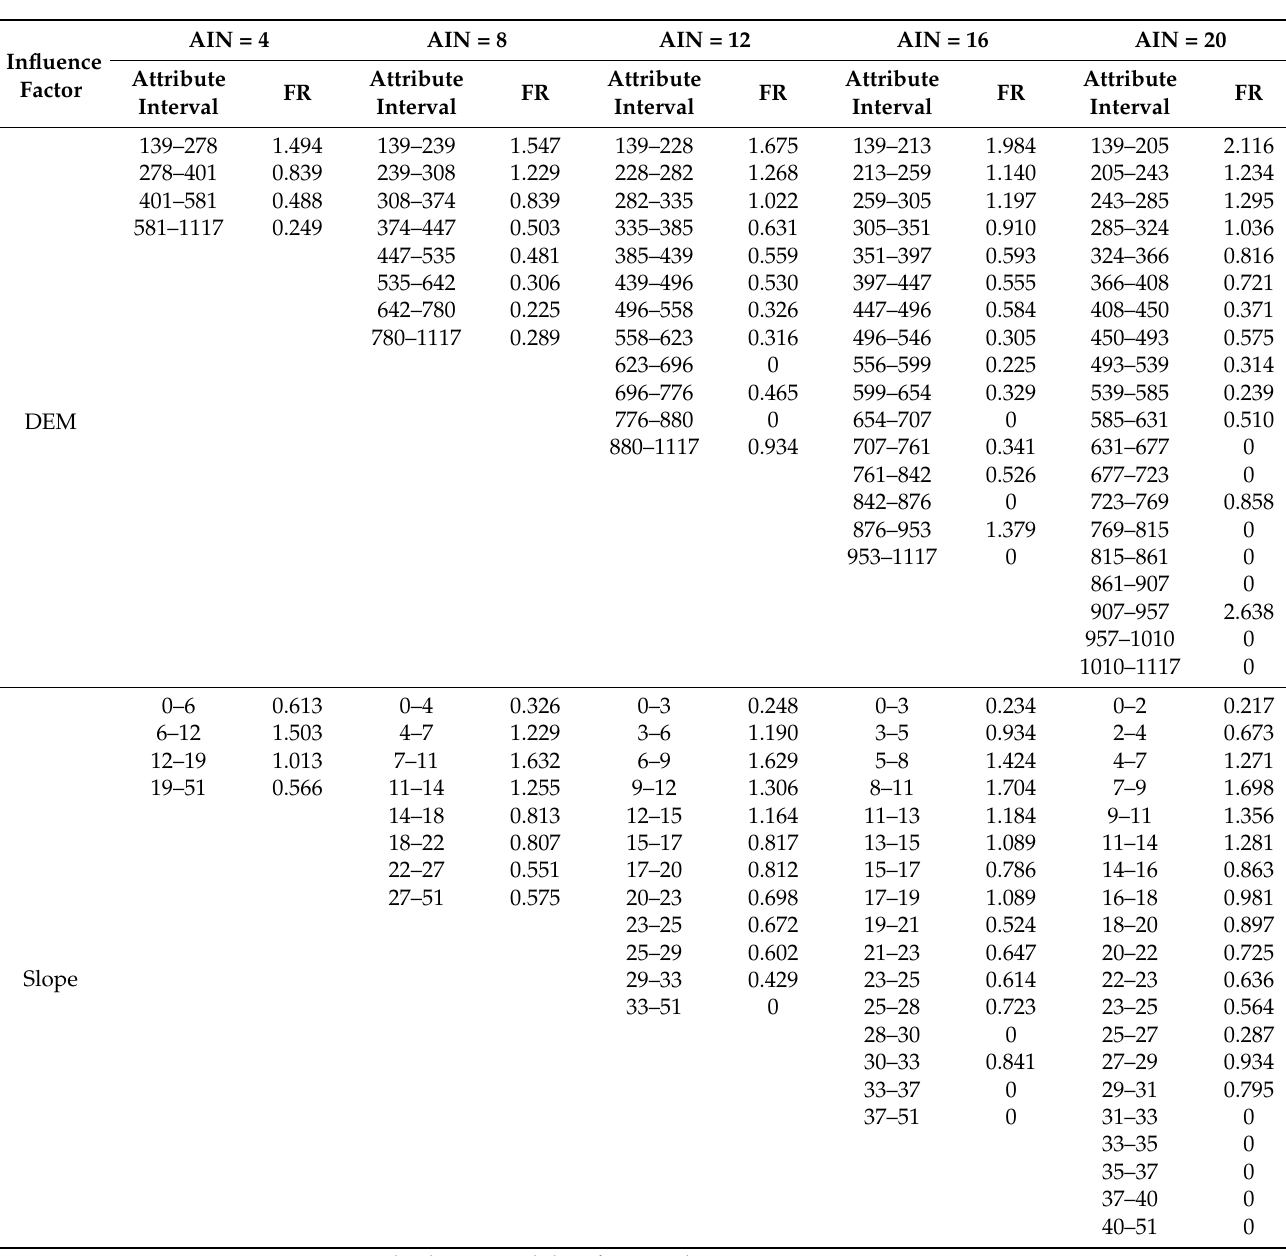
Table 2. Frequency ratio of topographical